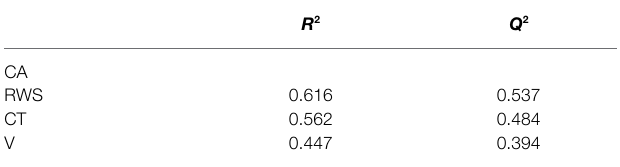
TABLE 12 Coefficients and parameters of the route.